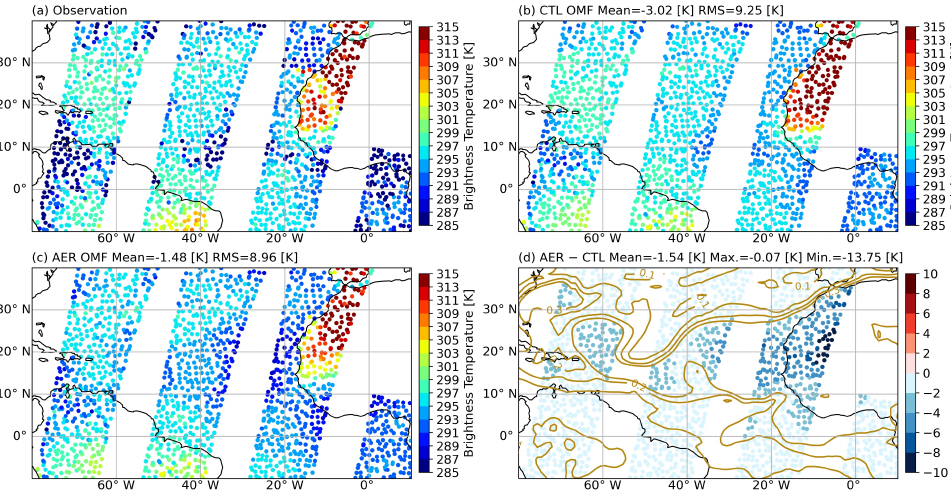
Figure 4. Comparison of BT at 10.39 µm of IASI on MetOp-A between CTL and AER at the cycle of August 5 12Z, 2017. ( a ) BT of observations ( b ) simulated BTs of CTL ( c ) simulated BTs of AER ( d ) BTs differences between CTL and AER. The AOD at 550 nm contour lines of 0.1, 0.2, and 0.3 are plotted in